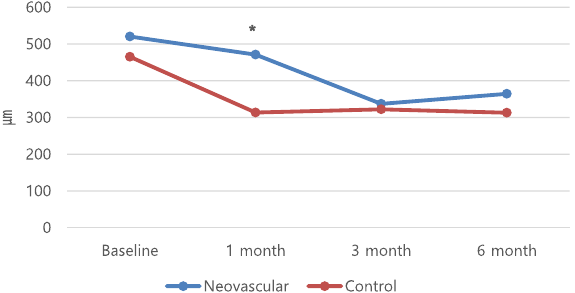
Figure 1. Changes in central retinal thickness after intravitreal bevacizumab injections in the neovascular and control groups of patients with central retinal vein occlusion. *Statistically significant by independent two- sample t-tests.